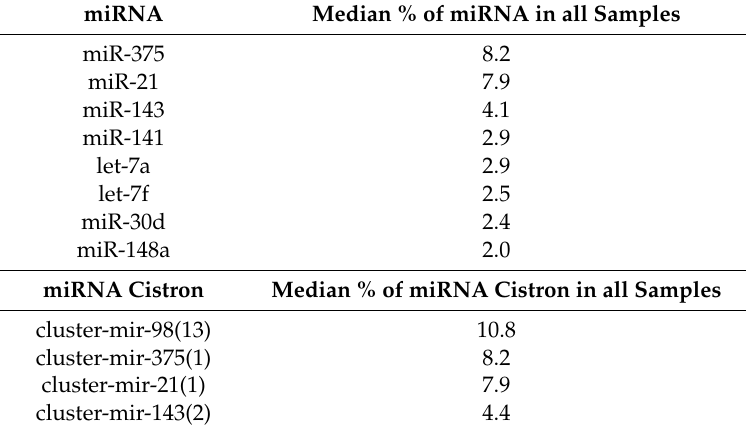
Table 2. Median expression of the top 0.5% overall highest expressed microRNAs (miRNAs) and miRNA cistrons.